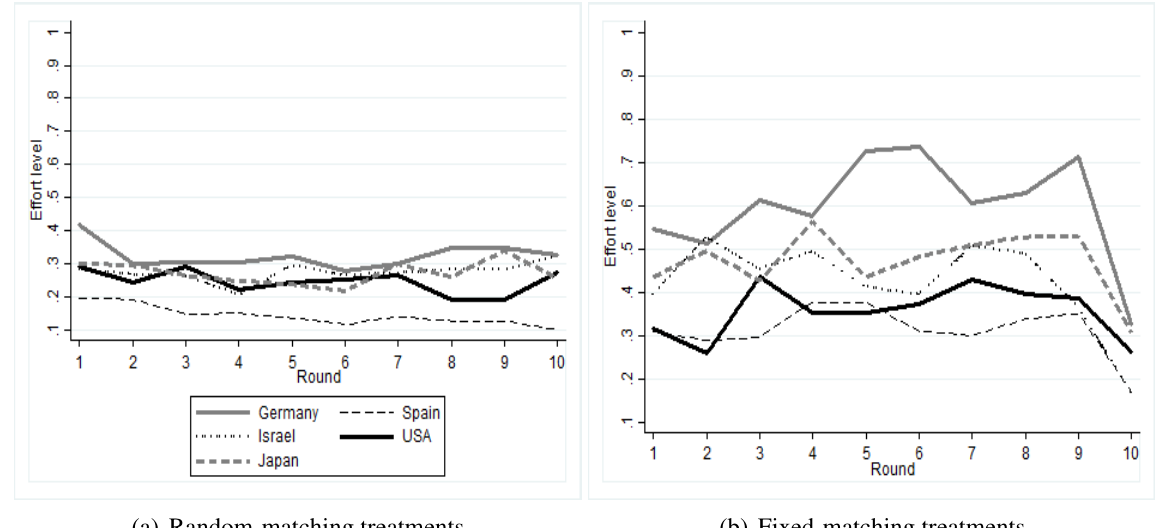
Figure B2. Evolution of average effort in the random- and fixed-matching